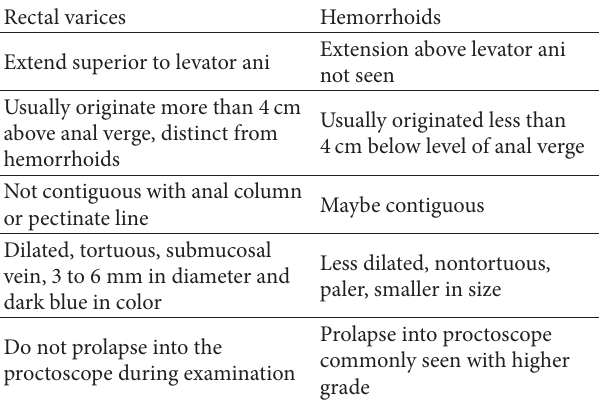
Table 3: Differentiating features on endoscopy between hemor- rhoids and rectal